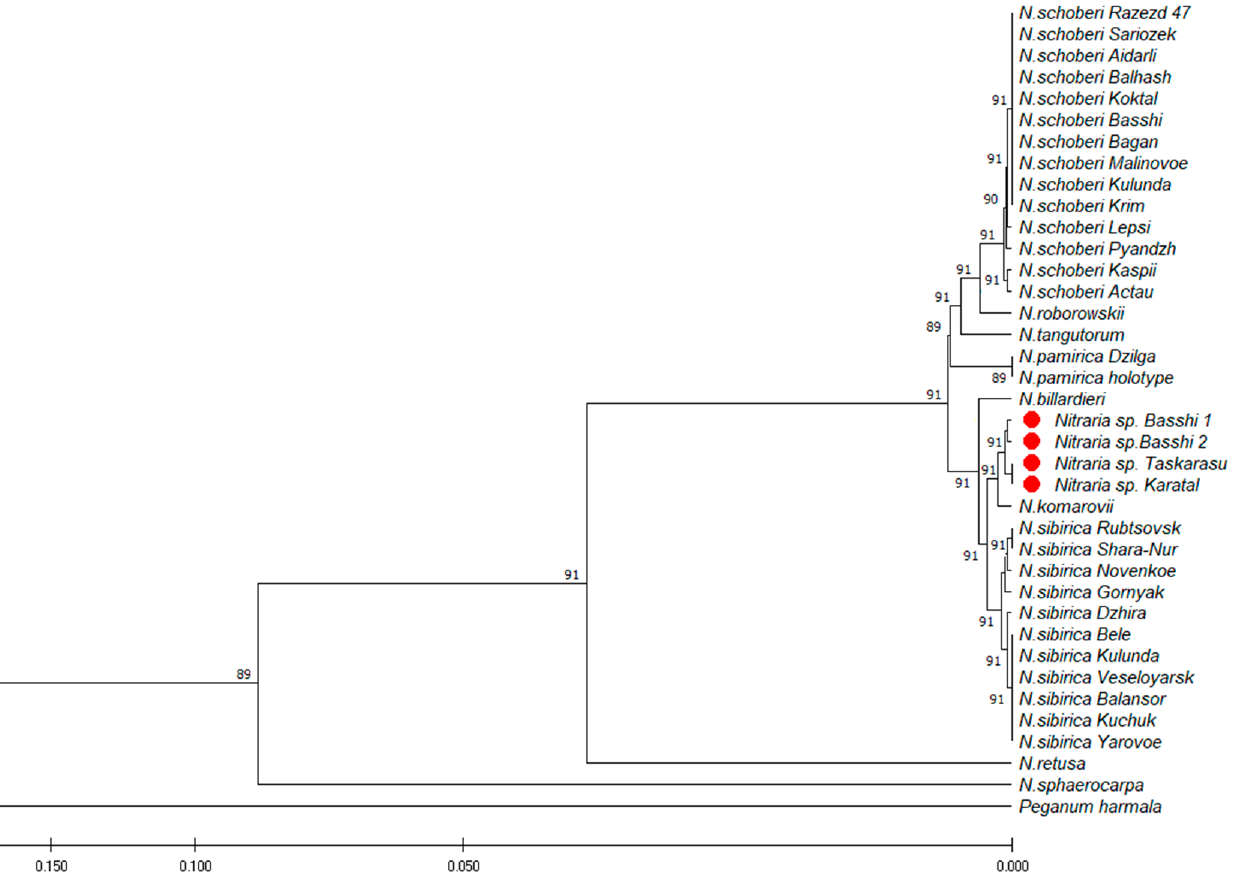
Figure 3. Phylogenetic tree inferred from the combined ITS and cpDNA data using the UPGMA method. The number near branches are bootstrap values (BS > 50%). Red symbols— N. iliensis .